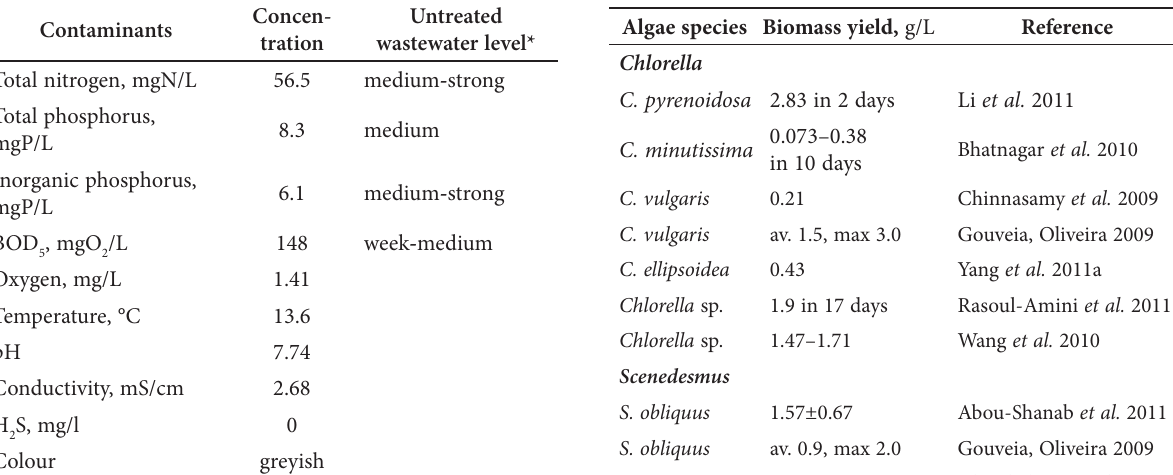
Table 2. Biomass production of Chlorella and Scenedesmus species based on references